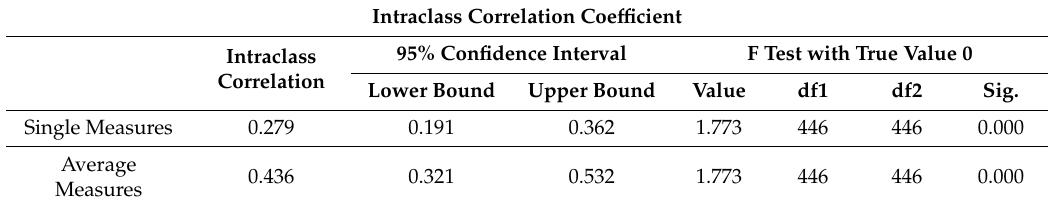
Table 3. Intraclass correlation coefficient of respondents’ assessments and experts’ assessments.